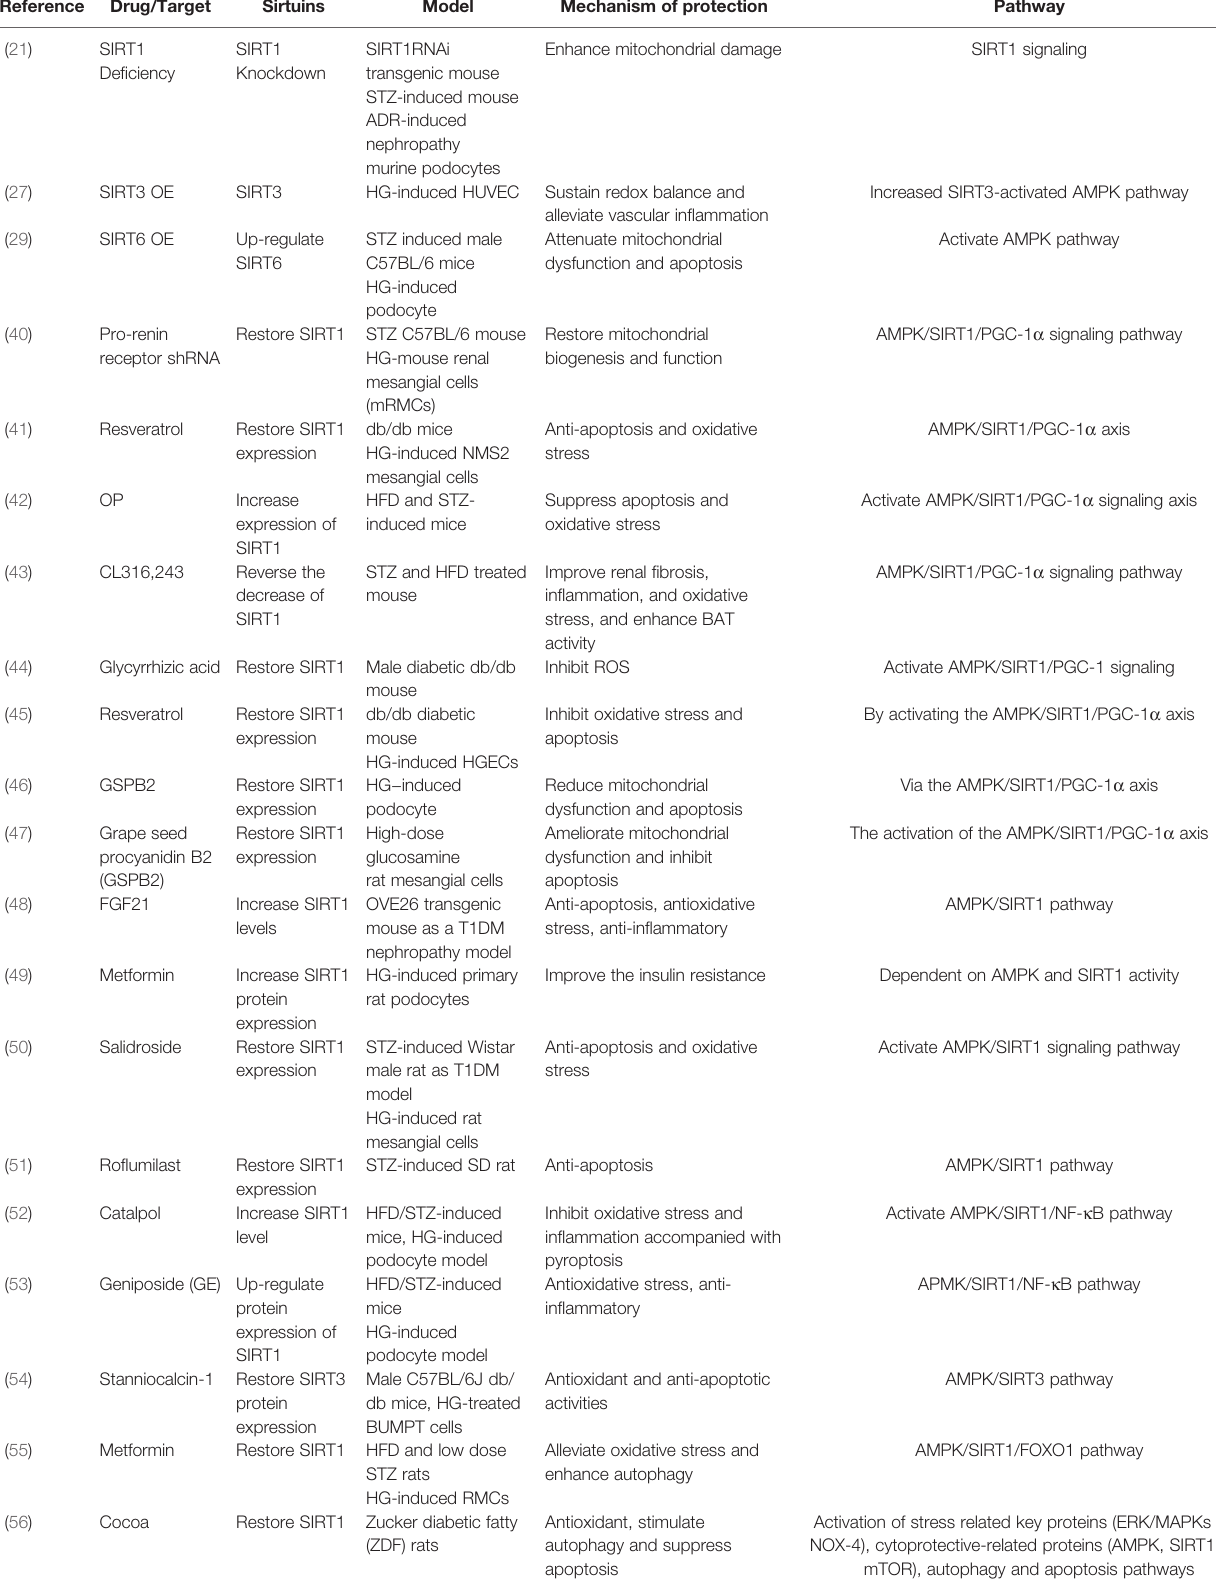
TABLE 2 | DKD studies on AMPK/sirtuins/PGC-1 a